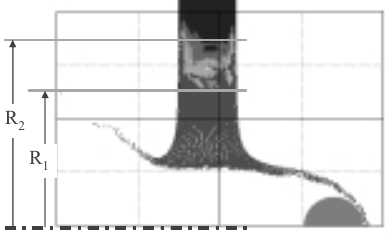
Fig. 8. Radii to be used in estimating damaged region of